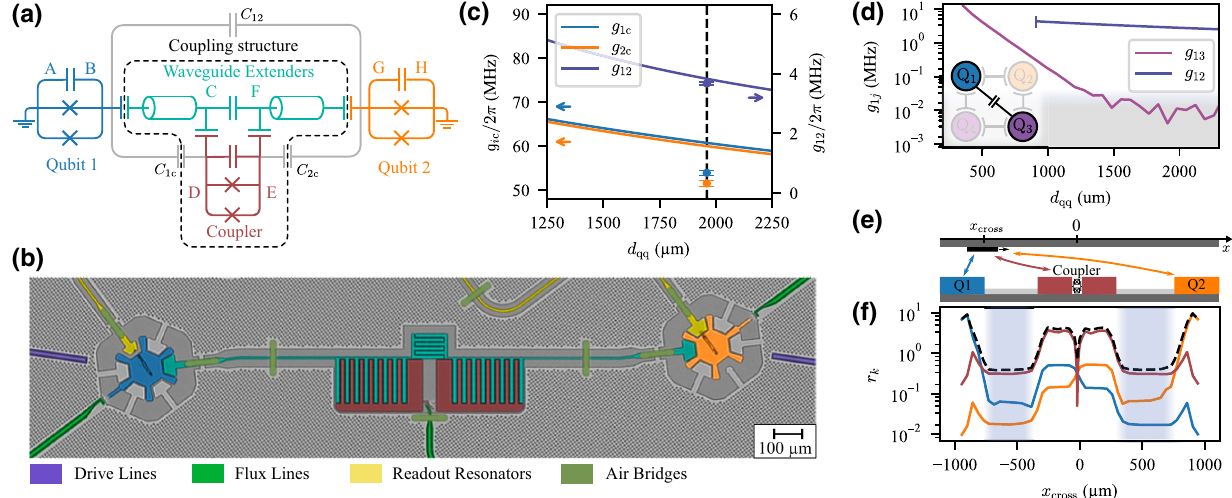
FIG. 1. (a) A quasi-lumped-element circuit diagram of qubits (blue and orange) coupled by a tunable coupling structure consisting of waveguide extenders (turquoise) and a floating coupler qubit (red). The gray lines show the effective lumped-element model for the coupling capacitances arising from the black waveguide extenders C and F. (b) A false-colored micrograph of the qubit-coupler-qubit system. The qubits, coupler, and waveguide extenders follow the color code from (a). The air bridges are colored nontransparently to protect unpublished intellectual property. (c) The simulation of the effective coupling strengths between qubit 1 and the coupler, g 1c , qubit 2 and the coupler, g 2c , and qubits 1 and 2, g 12 , for different qubit-qubit distances d qq (solid lines). The measured coupling values (dots with 68% confidence intervals) are shown for our device with d qq = 1960 µ m (dashed line). (d) The simulated spurious next-nearest-neighbor (NNN) coupling g 13 between Q and Q in a square-lattice configuration (schematic) and the nearest-neighbor 1 3 and Q . The gray shaded area indicates the region where the coupling (NN) coupling g 12 as a function of the distances d qq between Q 1 2 values fall below the simulation accuracy. (e) A schematic of a simplified flip-chip architecture, where the qubits and the coupler are connected via waveguide extenders (light gray) on the bottom chip and a long perpendicular transmission line (black) is crossing above the qubit-coupler structure on the top chip. (f) The simulated capacitance coupling ratios (see the main text) from each component to the transmission line [color code same as in (e)] at various crossing positions x cross of the transmission line, the total coupling (black dashed line), and the region for low-crosstalk crossings (blue